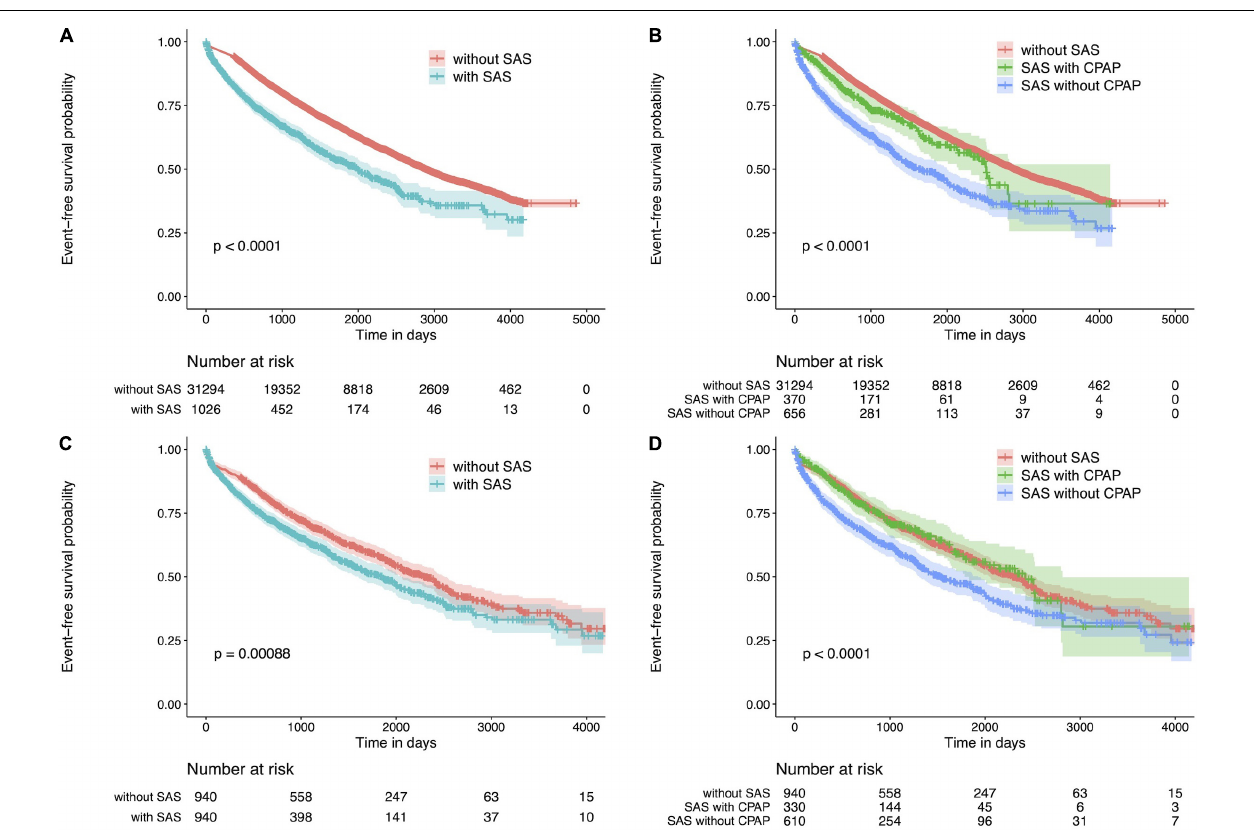
FIGURE 1 | Kaplan Meier plot for CKD patients. (A) Kaplan Meier plot of patients with or without SAS. CKD patients with SAS have a poor prognosis. (B) Kaplan Meier plot for patients with or without CPAP therapy or without SAS. The event rate was lower in the group treated with CPAP. (C) Kaplan Meier plot for CKD patients with or without SAS after propensity score matching. CKD patients with SAS have a poor prognosis. (D) Kaplan Meier plot for CKD patients with or without CPAP therapy or without SAS after propensity score matching. The event rate was lower in the group treated with CPAP. CKD, chronic kidney disease; SAS, sleep apnea syndrome.